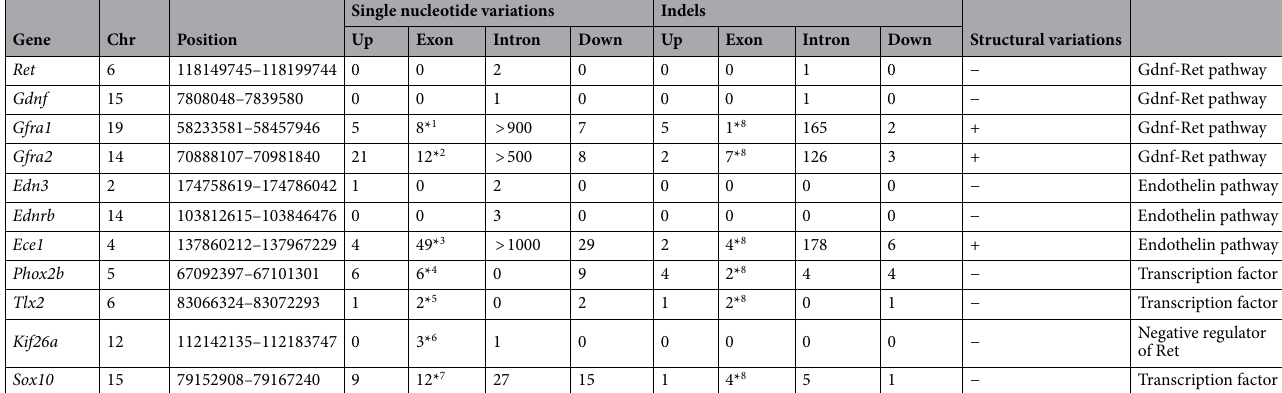
Table 1. Genetic polymorphisms in C57BL/6 and BALB/c mice. *1 5 ′ UTR variant = 3, 3 ′ UTR variant = 3, missense variant = 2. *2 5 ′ UTR variant = 2, 3 ′ UTR variant = 6, synonymous variant = 4. *3 5 ′ UTR variant = 1, 3 ′ UTR variant = 28, synonymous variant = 19, missense variant = 1. *4 3 ′ UTR variant = 6. *5 3 ′ UTR variant =